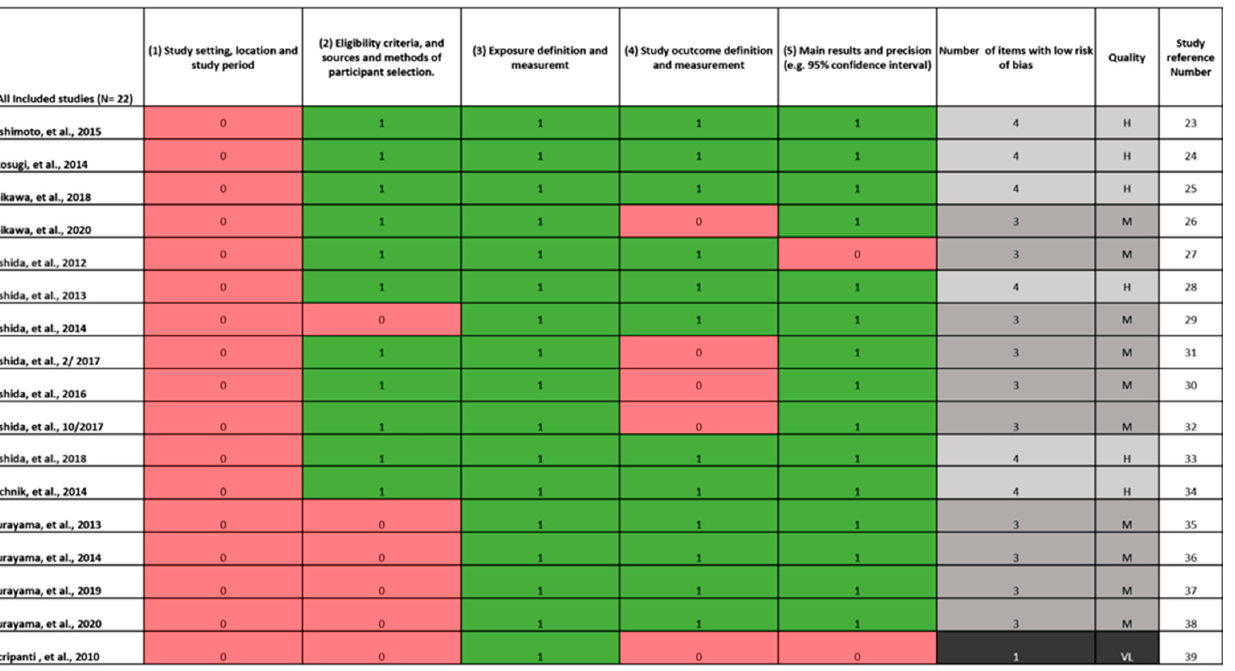
Figure 2. Modified STROBE criteria quality assessment. H = High quality. M = Moderate Quality. L = Low Quality. VL = Very Low Quality = Excluded.